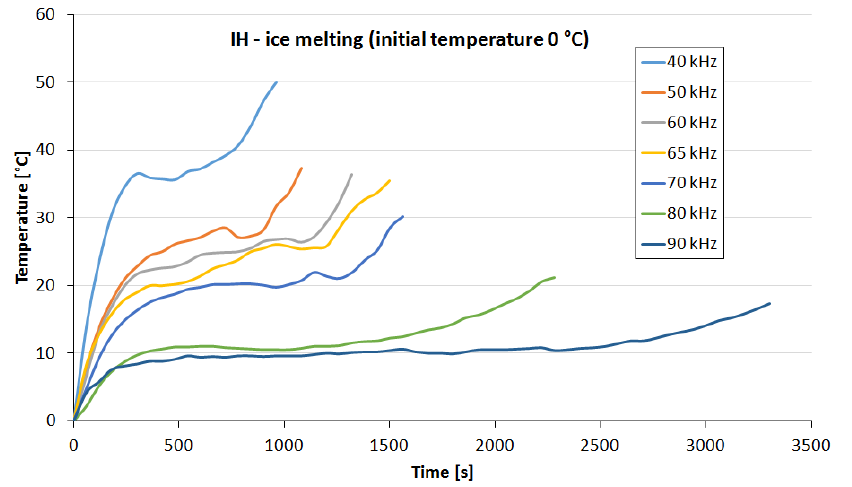
Figure 15. Temperature of IH device surface vs. time at different operating frequencies for an initial temperature of 0 °C.